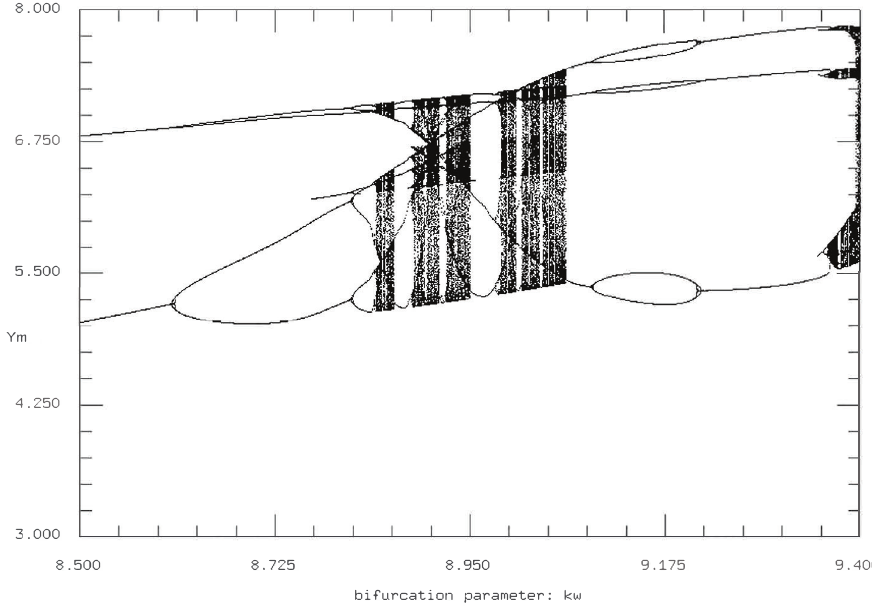
Figure 13. Bifurcation diagram for maxima of Y m with k w and k f m = 0 and other parameters from Table 1.